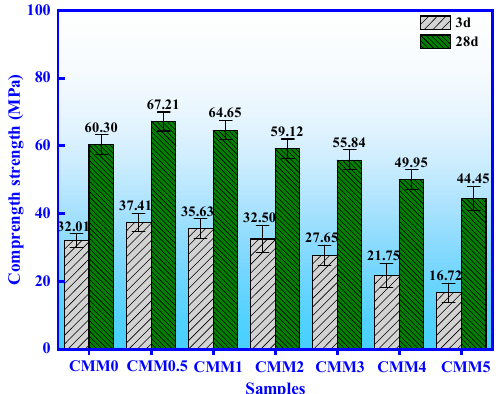
Figure 5. Compressive strength of the CMM cured for 3 to 28 days. The CMM0, CMM0.5 and CMM5 were selected to investigate compressive strength of CMM mortar under autoclaved curing condition. As shown in Figure 6, the compressive strength of CMM mortar increases with the autoclaved time. The dispersion coefficients of CMM0, CMM0.5 and CMM5 are lower than 0.15 based on standard deviation calculation. This phenomenon shows that the experimental value of autoclaved strength is closer to the mean value. The compressive strength of CMM0–12 h (OPC) mortar is 87.31 MPa, which is higher than that of standard curing for 360 days (70 MPa) [32]. This result indicates that the hydration reaction rate of OPC is raised by autoclaving relative to standard curing. The compressive strength of CMM showed an inverted V-shape with the Ca/(Si+Al) mass ratio from 2.38 to 0.83, and the compressive strength of CMM0.5 was the highest. This proves that the hydration degree of CMM0.5 under autoclaved condition is higher based on the synergy of CFB fly ash and OPC. These rules are consistent with Figure 5.